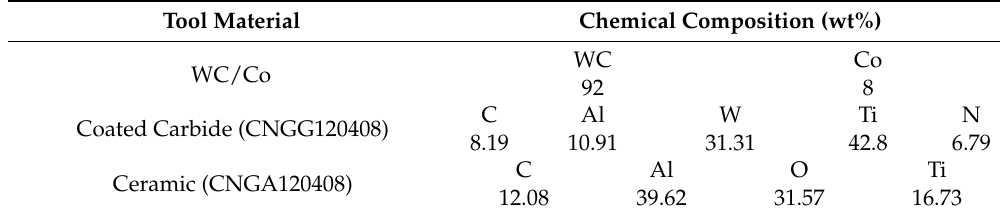
Table 1. Percentage composition of the three tool materials.